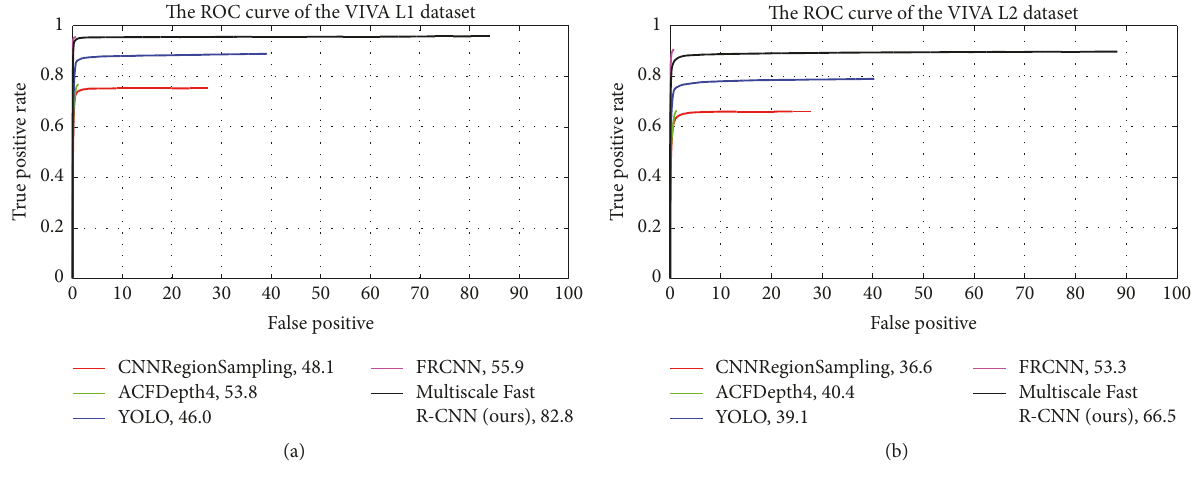
Figure 13: ROC curve on the VIVA hand detection dataset: (a) L1; (b) L2.